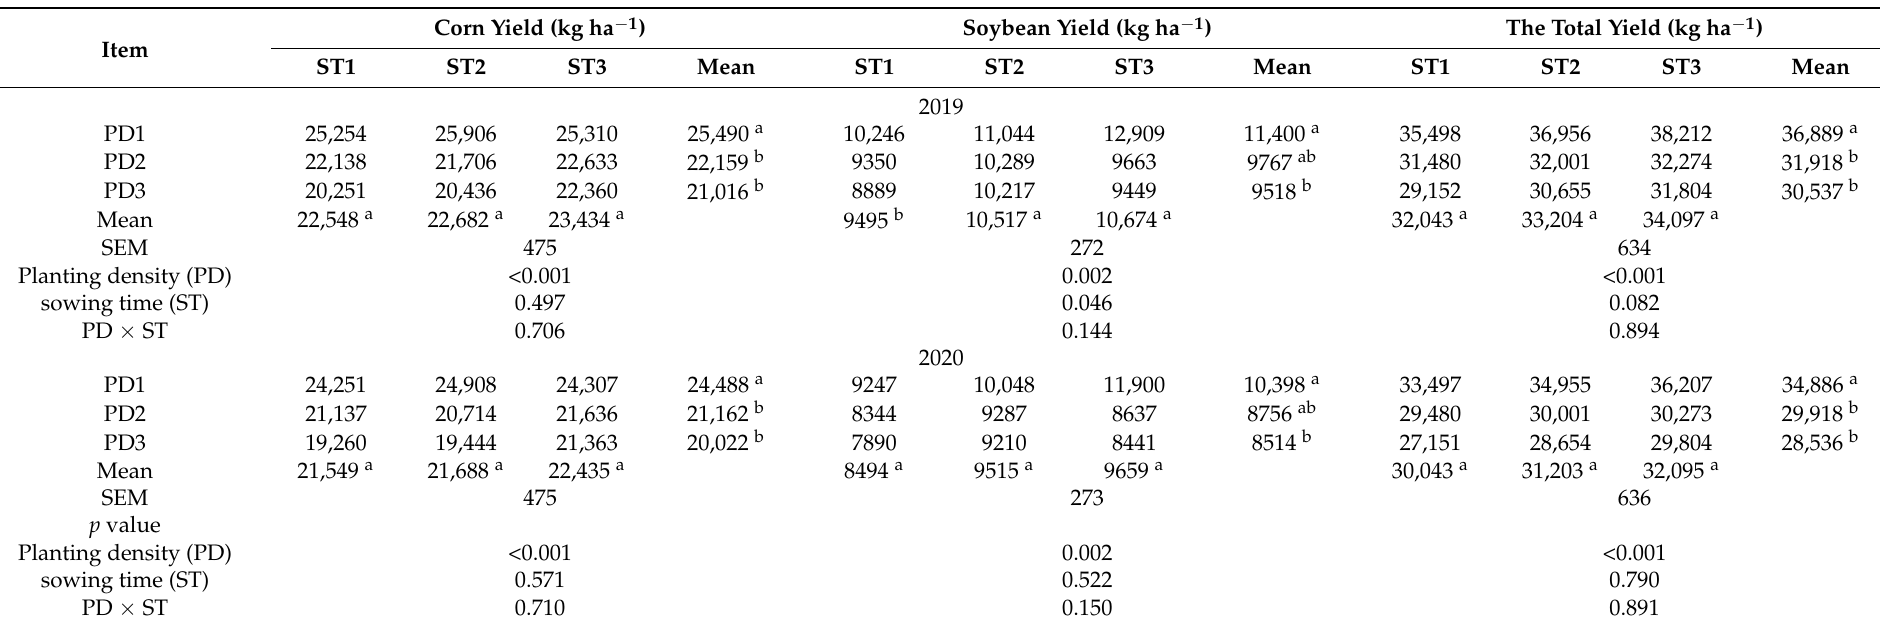
Table 3. Effects of sowing time and planting density of soybean on dry-matter yield (kg ha − 1 ) in corn-soybean strip intercropping